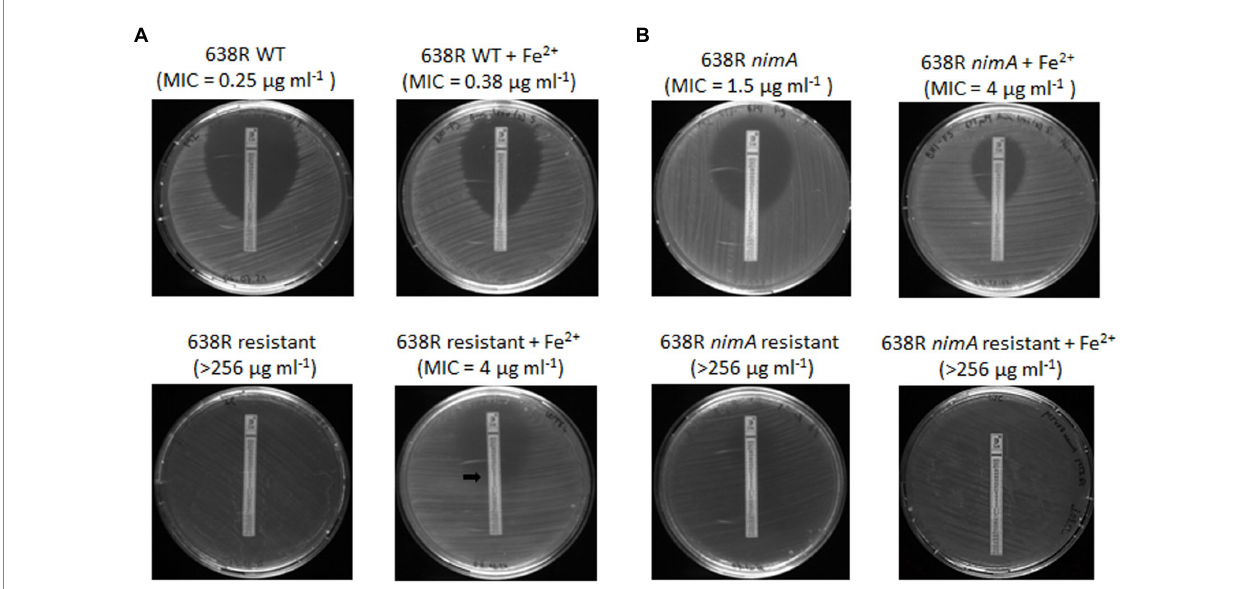
FIGURE 3 Susceptibilities of (A) 638R and 638R R , and (B) 638R nimA and 638R nimA R as determined by Etest, either with or without supplementation of 100 μ M ferrous iron sulfate. Due to the fainter appearance of 638R R as compared to 638R, the point of intersection with the Etest strip is indicated by a black